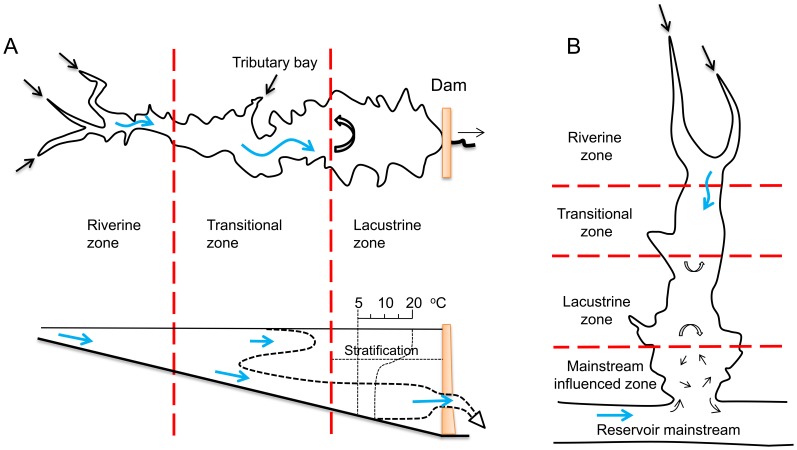
Schematic illustration of longitudimal zonation in a reservoir (the left modified from Ref [10]), and in a tributary embayment (right).